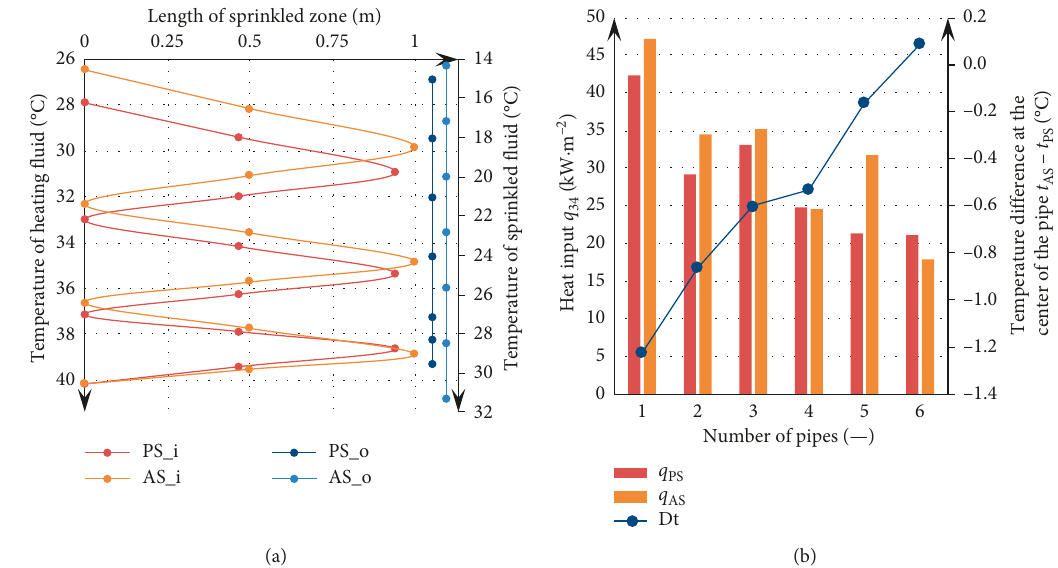
Figure 3: Impact of sprinkled area length on temperature changes of heating liquid in loop (a) and on sampled heat flux (b).